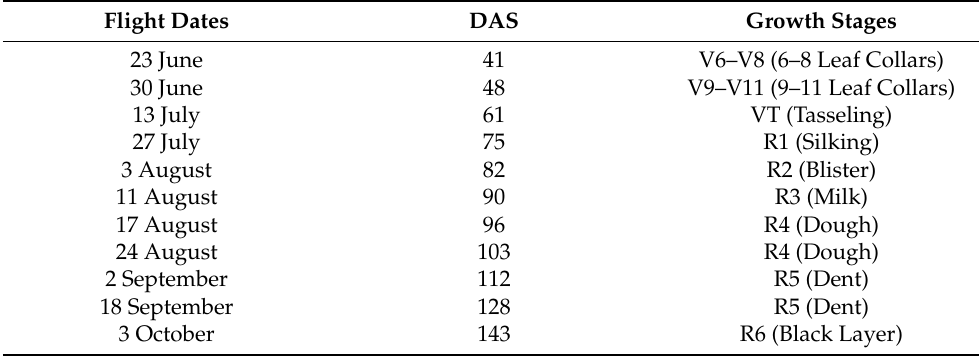
Table 1. UAV survey dates, days after seeding, and growth stages. Flight Dates